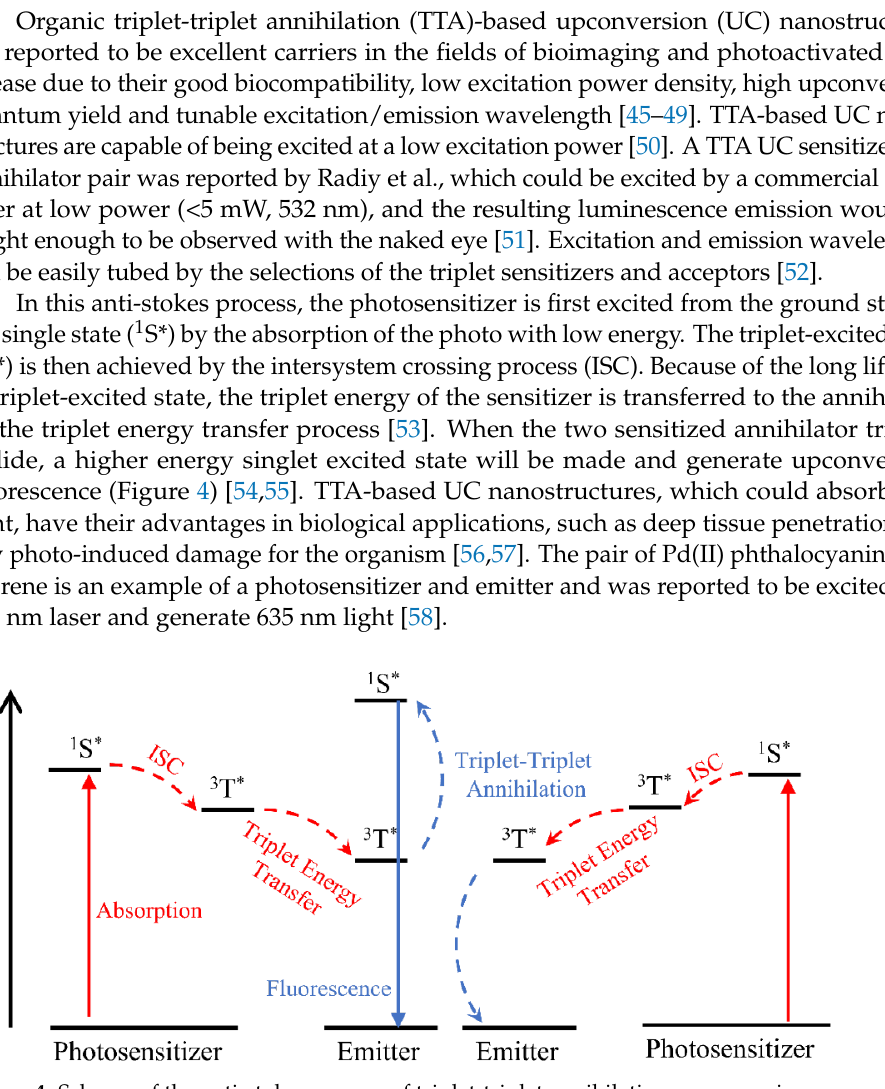
Figure 4. Scheme of the anti-stokes process of triplet-triplet annihilation upconversion